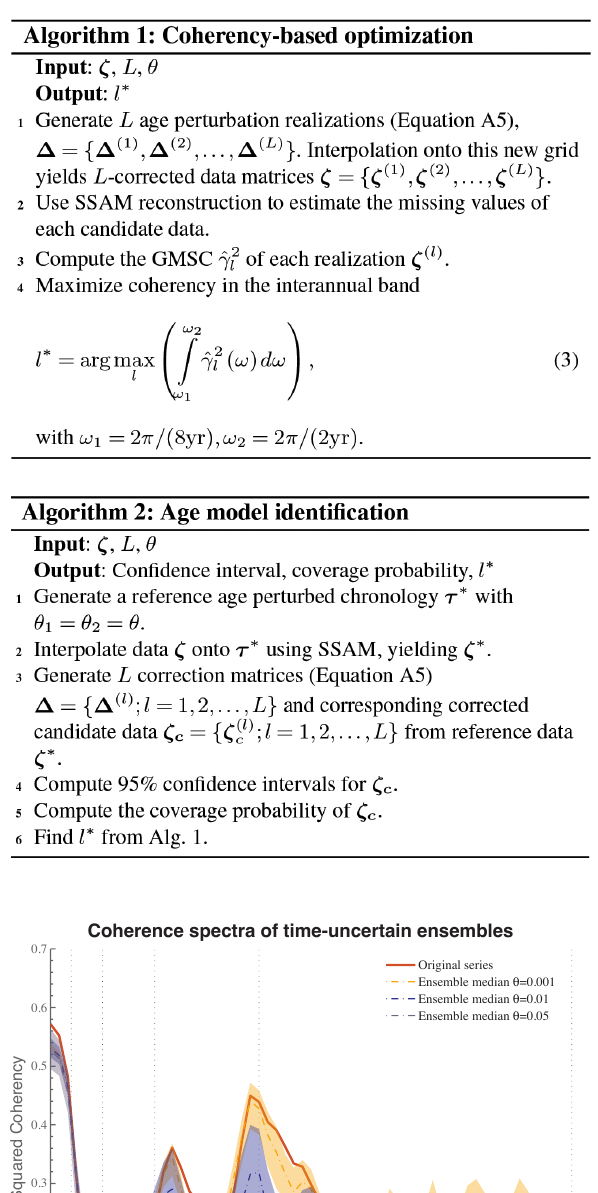
Table 3. Computational steps to identify an optimal chronology.